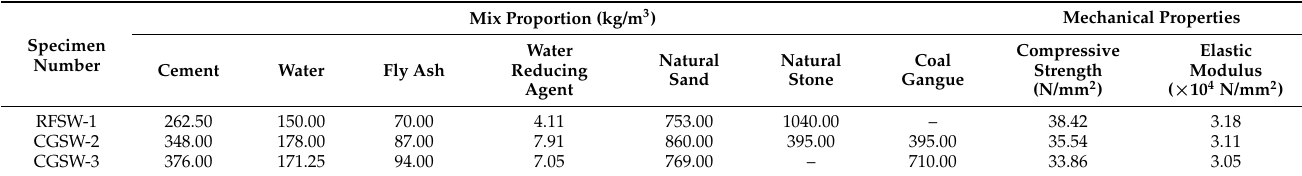
Table 3. Mix proportion and main mechanical properties of the coal gangue concrete.